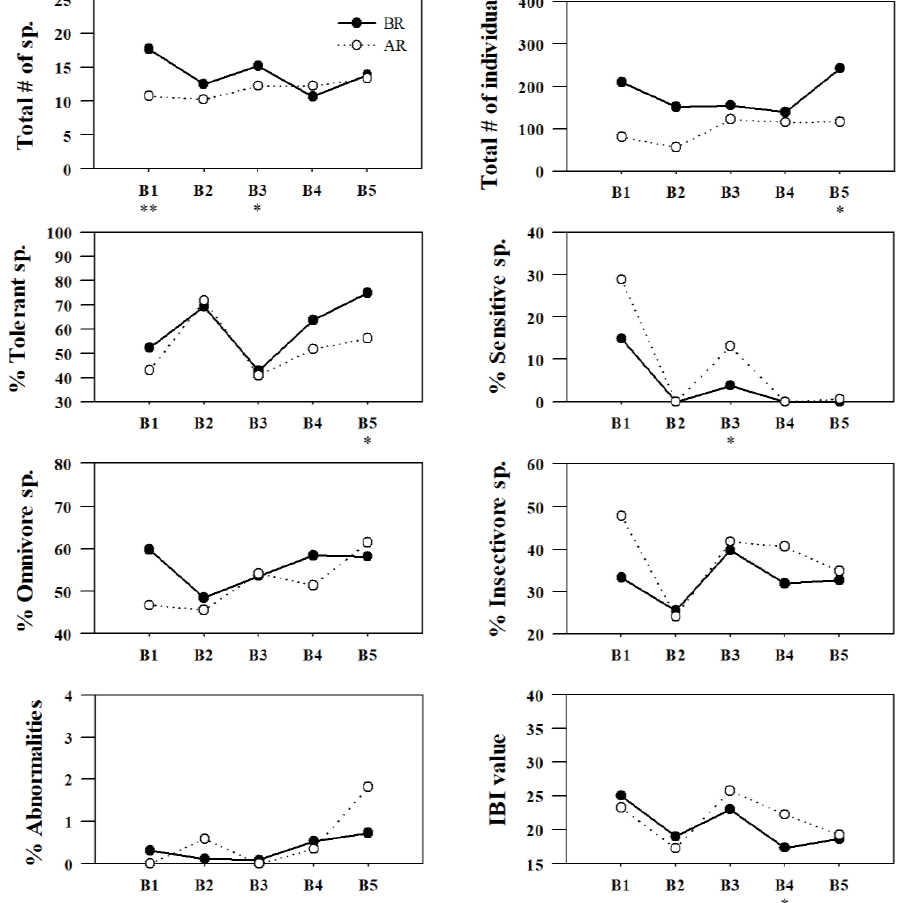
Figure 7. Spatial variation in fish assemblages (trophic and tolerance guilds) as well as IBI values as ecological health parameters based on restoration measures in Gap-stream (BR = before restoration, 2007–2010; AR = after restoration, 2013–2016, * = p < 0.05, ** = p < 0.01).